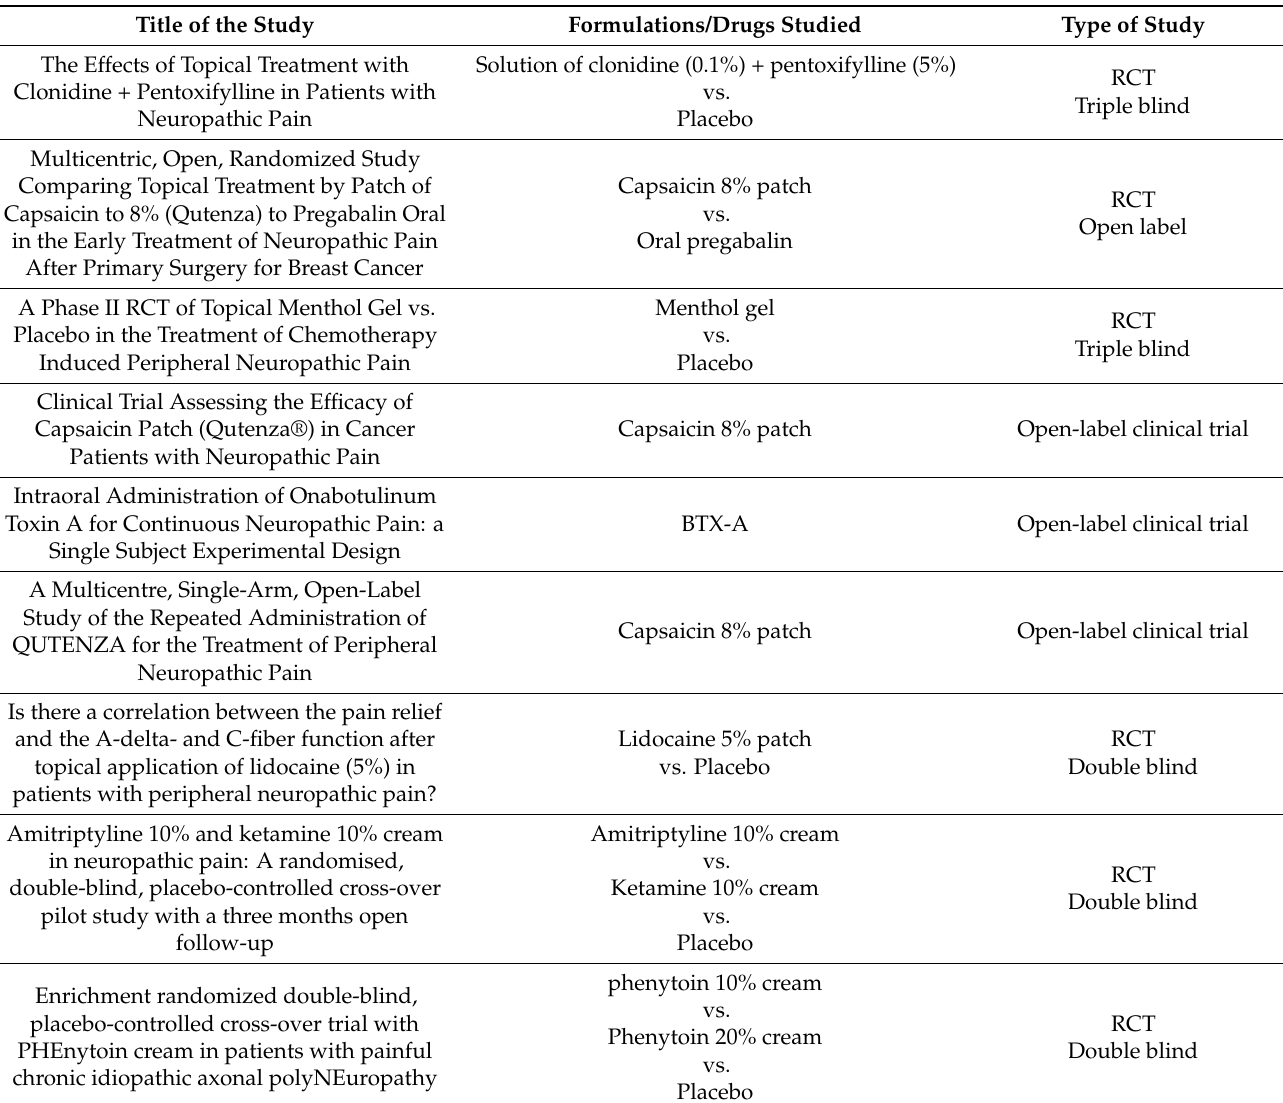
Formulations/Drugs